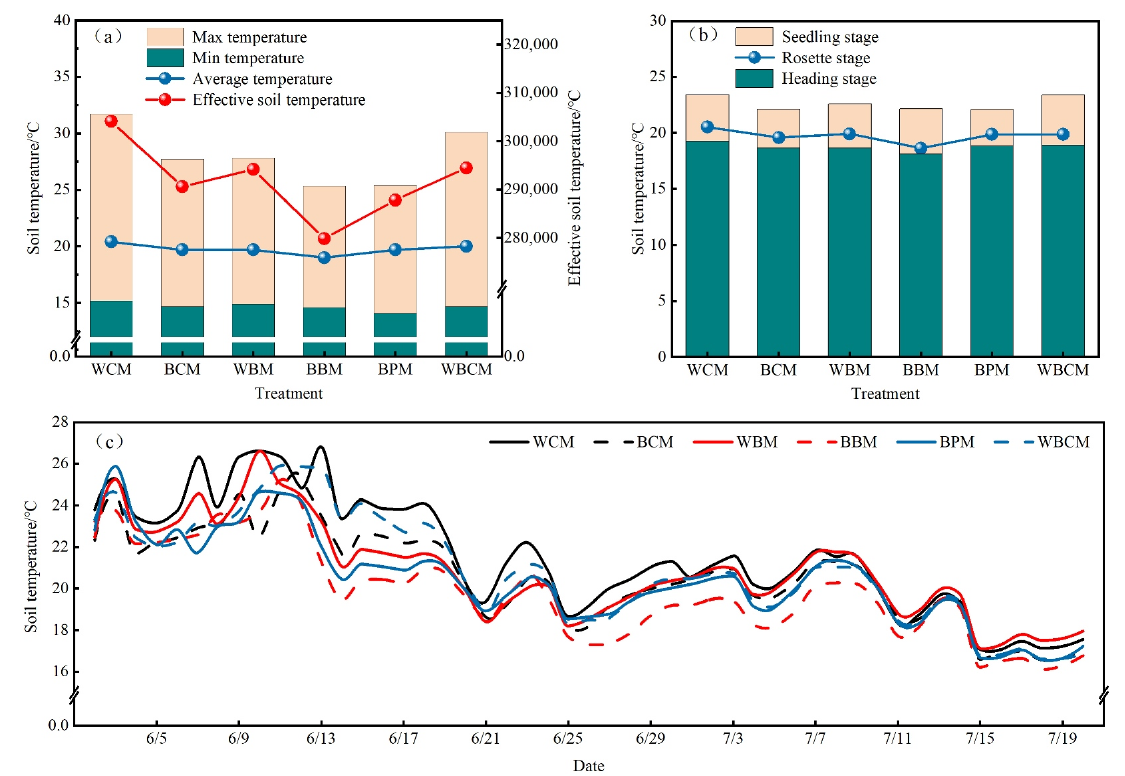
Figure 3. ( a – c ) Effects of different treatments on soil temperature and effective accumulated tem-